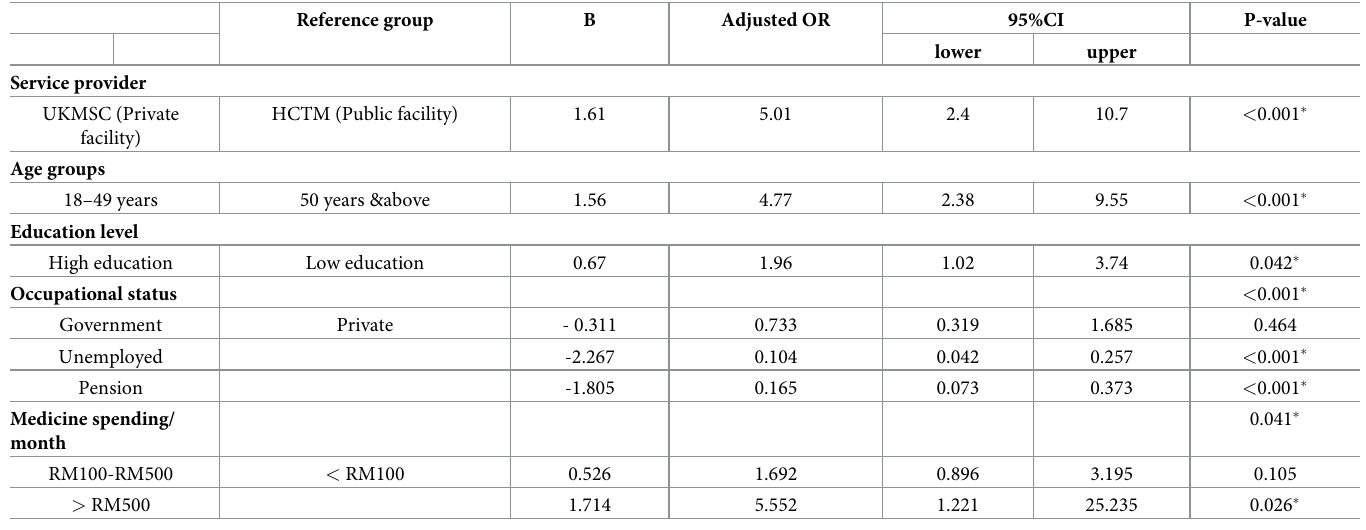
Table 5. Multivariate analysis of health insurance status for sociodemographic and economic